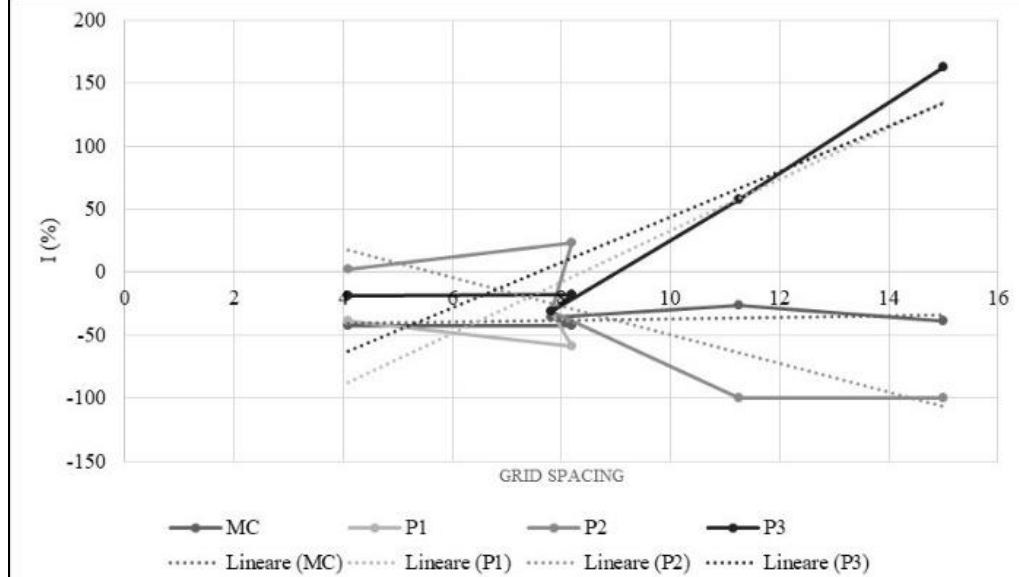
Figure 15. Relationship between I index and grid spacing in X direction.